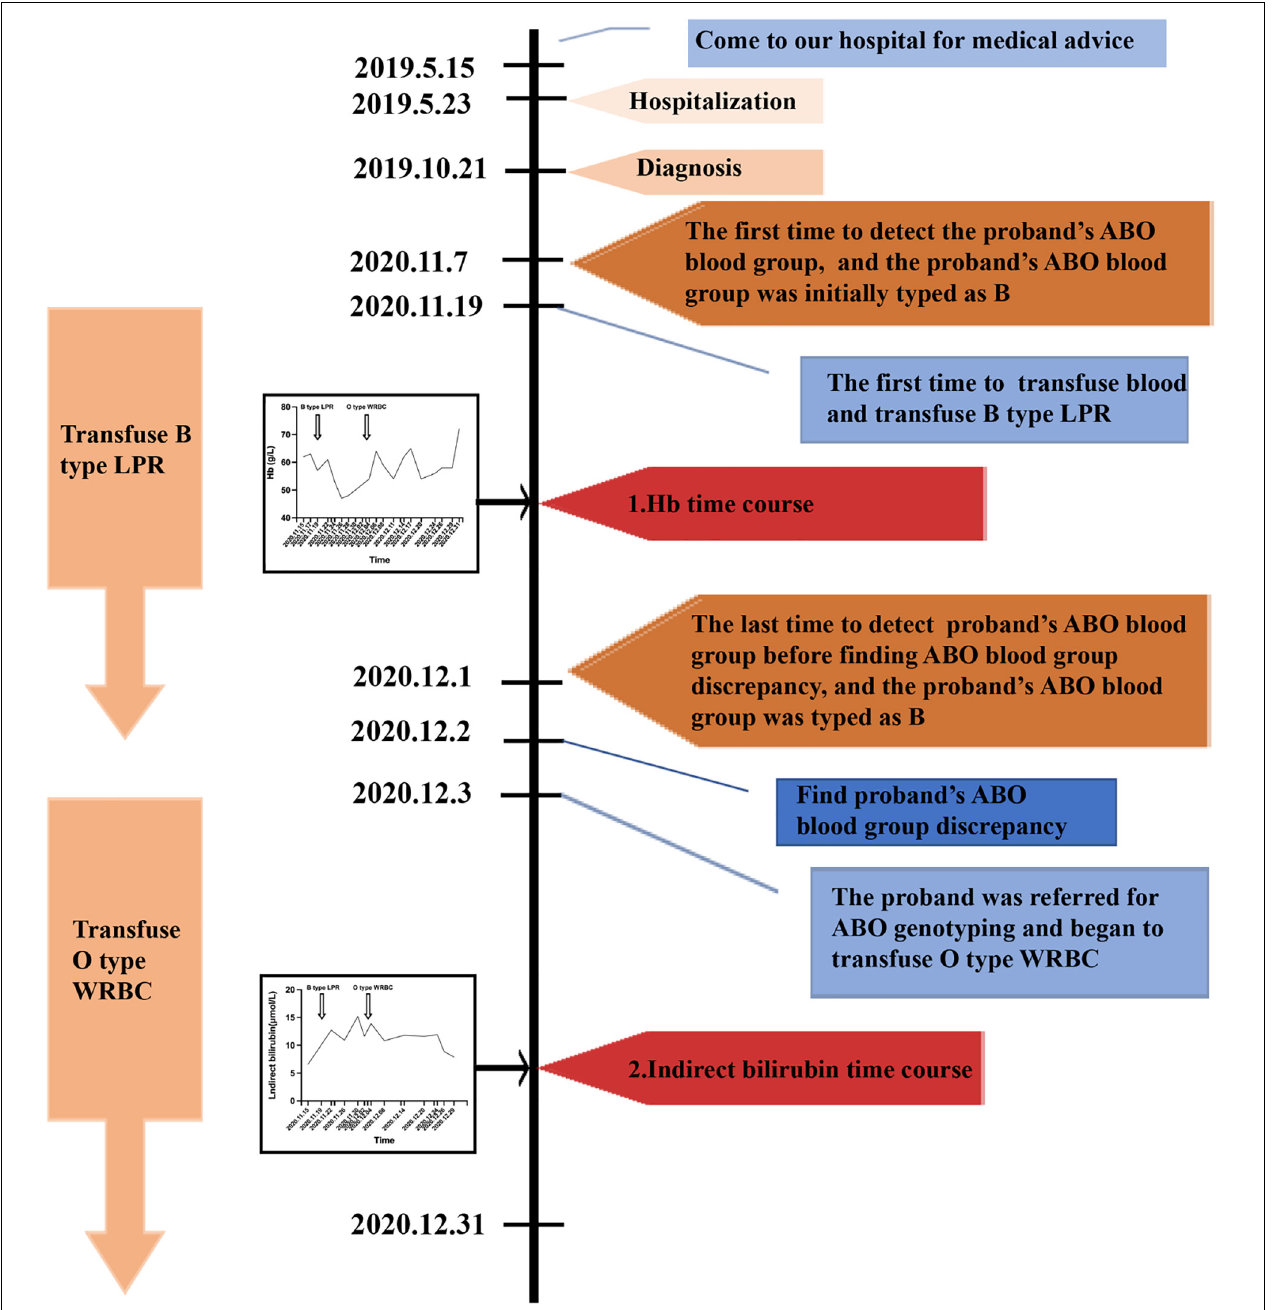
FIGURE 1 | A timeline of the patient’s medical history and course of care. Hb, hemoglobin; LPR, leukocyte poor red blood cell; WRBC, washed red blood cell.